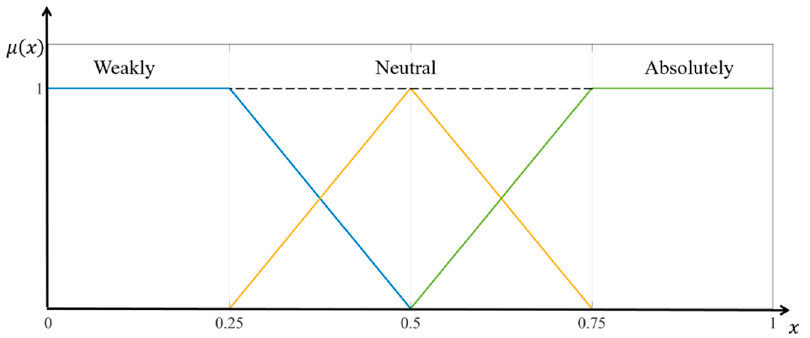
Figure 7. Three-scale self-confidence linguistic terms.